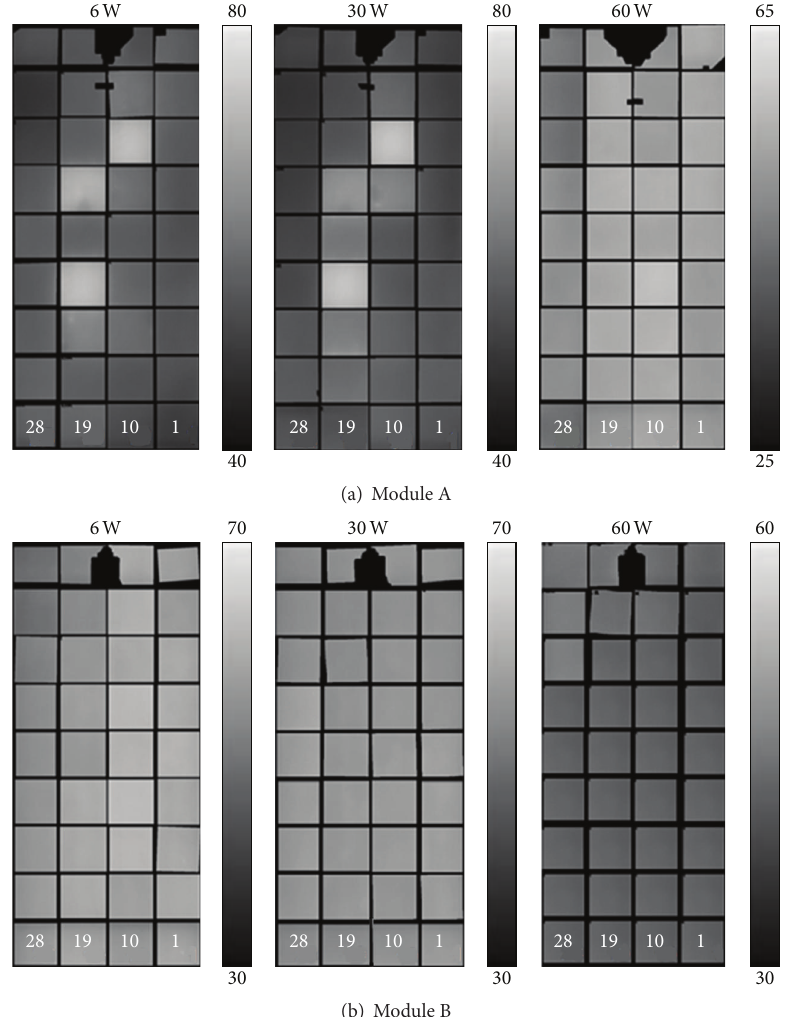
Figure 3: Temperature of two mc-Si modules at three operating points.